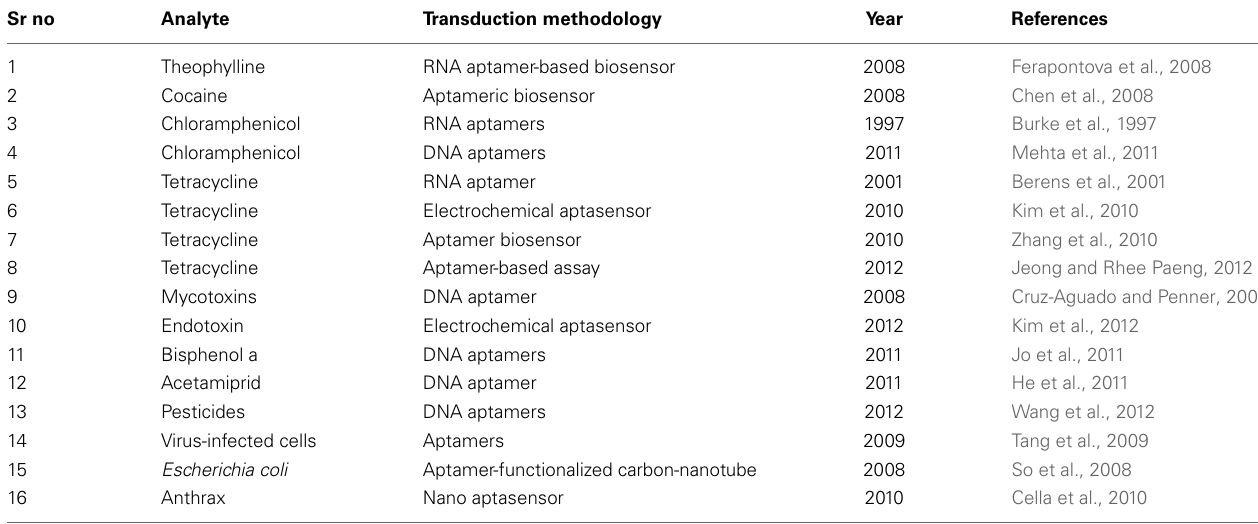
Table 1 | Electrochemical aptasensors designed for the detection of different target